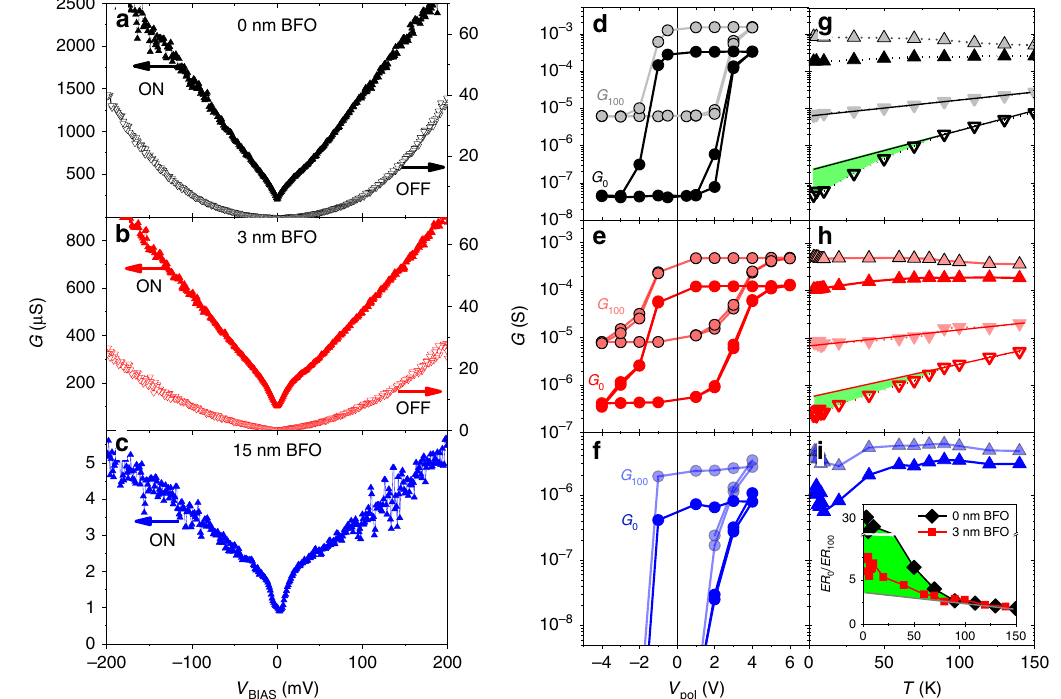
Fig. 2 Conductance switching. Differential conductance G = d I /d V BIAS as a function of applied V BIAS , measured at T = 3.2 K after application of V pol > 0 V (ON state) and V pol < 0 V (OFF state) for three different BFO thickness . a 0 nm BFO-Mn ( V pol = ± 3 V), c 3nmBFO-Mn ( V pol = + 6 V and − 4V) and e 15nmBFO-Mn ( V pol = ± 4 V). For the latter thickness, the conductance in the OFF state is unmeasurably low. d , e , f show the switching between the ON and OFF state. This is illustrated by G 0 ( V pol )and G 100 ( V pol ), that is, the conductance measured at zero bias and at V BIAS = 100 mV after application of different V pol , which were cycled repeatedly from negative to positive and vice versa. For the same samples as in a – c . g – i show G o ( T ) and G 100 ( T ) after poling at 3.2 K. The straight lines superposed to the measurements in the OFF state are a extrapolation of the high temperature trend of G ( T ). Green regions highlight the deviation of G o ( T ) from the high temperature trend. The inset in (i) shows the ratio between the electroresistance ( ER = G ON / G OFF ) at zero bias and that under V BIAS = 100 mV, that is ER 0 / ER 100 , as a function of temperature for the 0 nm BFO (diamonds), and 3 nm BFO junction (squares symbols). ER 0 / ER 100 is calculated from the data in 2 g and 2 h. The green region highlights the deviation of ER 0 / ER 100 from the high temperature trend. The vertical axis presents a break between ER 0 / ER 100 = 10 and ER 0 / ER 100 = V BIAS = 100 mV (see the G 100 loop, light-coloured circles). The same bias dependence is evident in Fig. 2e.